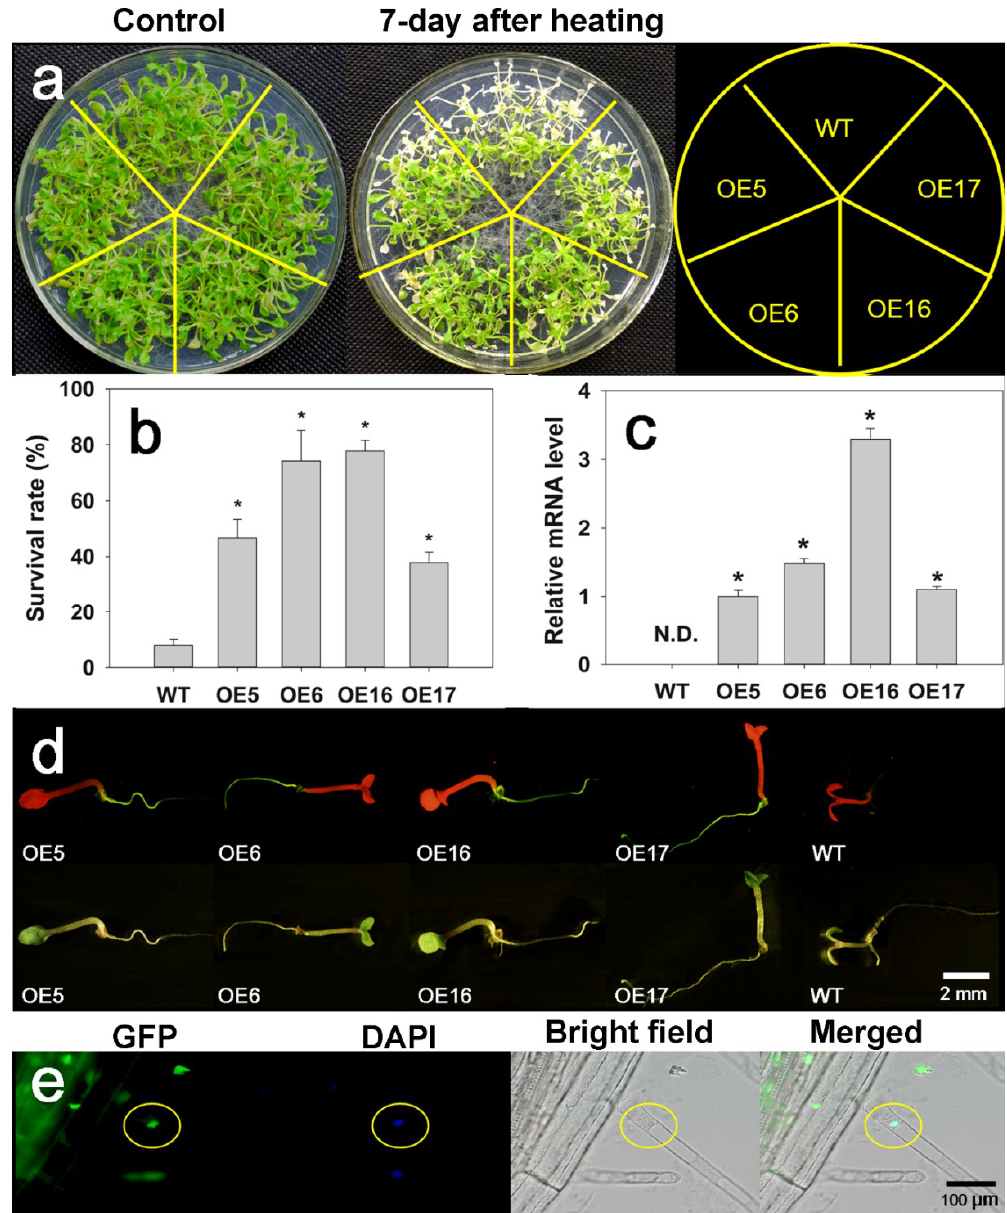
Figure 5. Physiological characterization of FaHsfC1b ‐transgenic Arabidopsis seedlings. ( a ) Showed three‐week‐old WT and transgenic Arabidopsis recovered from heat treatment (45 °C for 5 h) or grown in normal conditions. ( b ) Percentage of plants that survived after 7 - day recovery from heat treatment. Values were means ± SD of five independent lines, fifteen seedlings in each dish for each line, and three biological replications. Asterisks on the top of bars indicated significant differences between WT and transgenic lines according to Fisher’s protected LSD test ( p < 0.05). ( c ) Relative mRNA expression levels of FaHsfC1b in different lines. Values are means ± SD of five independent lines and three biological replicates (with three technical replications for each biological replication). N.D. indicated ‘not detectable’. ( d ) Expression of FaHsfC1b‐GFP fusion protein in FaHsfC1b transgenic lines. Five‐day‐old seedlings in culture dish were observed under stereo fluorescence microscope. The upper row indicates seedlings under fluorescence light, while the lower row indicates seedlings under white light. ( e ) Localization of FaHsfC1b protein in root tips of transgenic plants. Five‐day‐old seedlings in culture dishes were observed under fluorescence microscope BX53 with higher magnification.